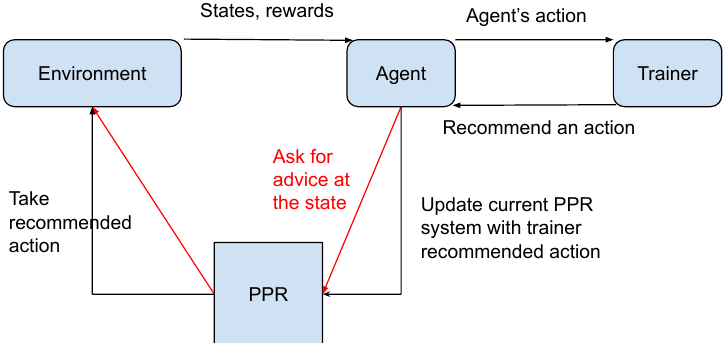
Figure 2. Process flow of an interactive reinforcement learning agent using the PPR system. After receiving advice from the trainer, the agent will store the action in the PPR model. In the iteration not receiving advice from the trainer, the agent will check and reuse the old advice (red arrows) from the past.